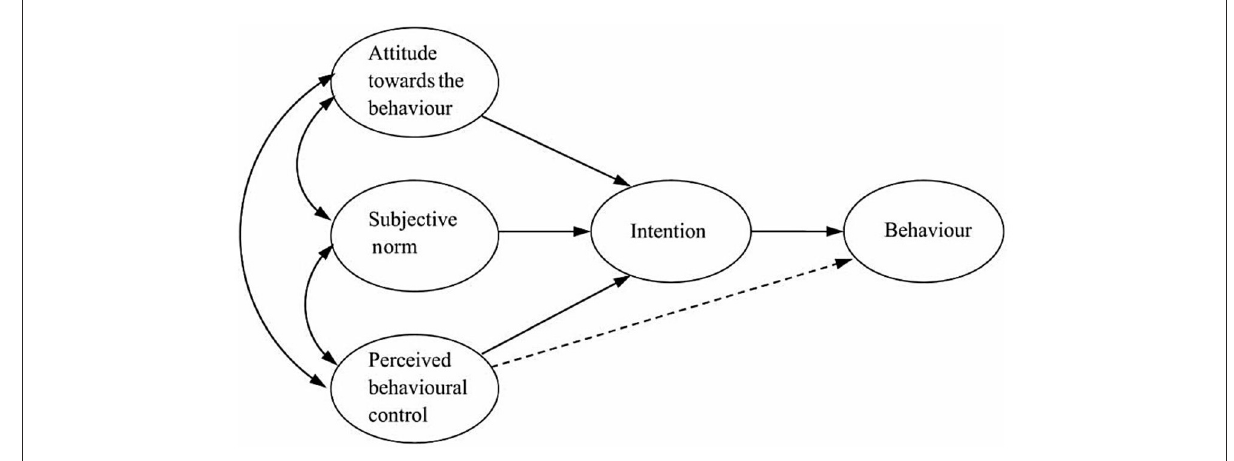
FIGURE1 Ajzen’s theory of planned behavior (TPB) (13).